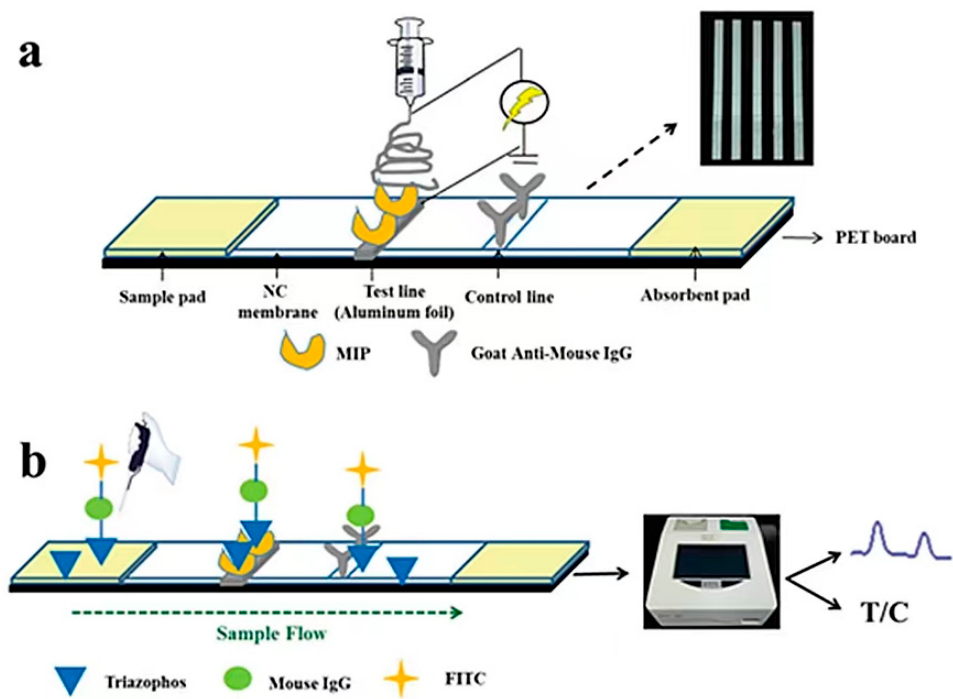
Figure 11. ( a ) Structure diagram of the molecularly imprinted electrospun test strip and ( b ) direct competitive fluorescence detection process ([128]).